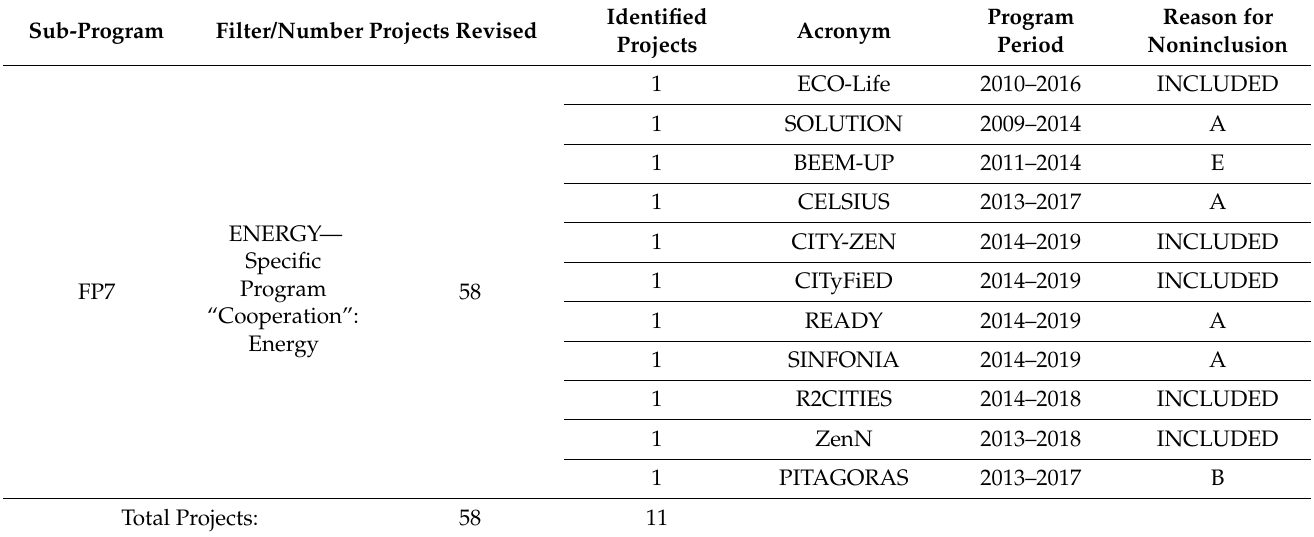
Table 3. Results for Projects Corresponding to the FP7 Program.